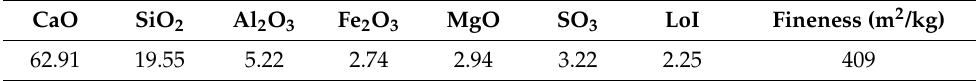
Table 1. Chemical composition (% by mass) and fineness of the cement.